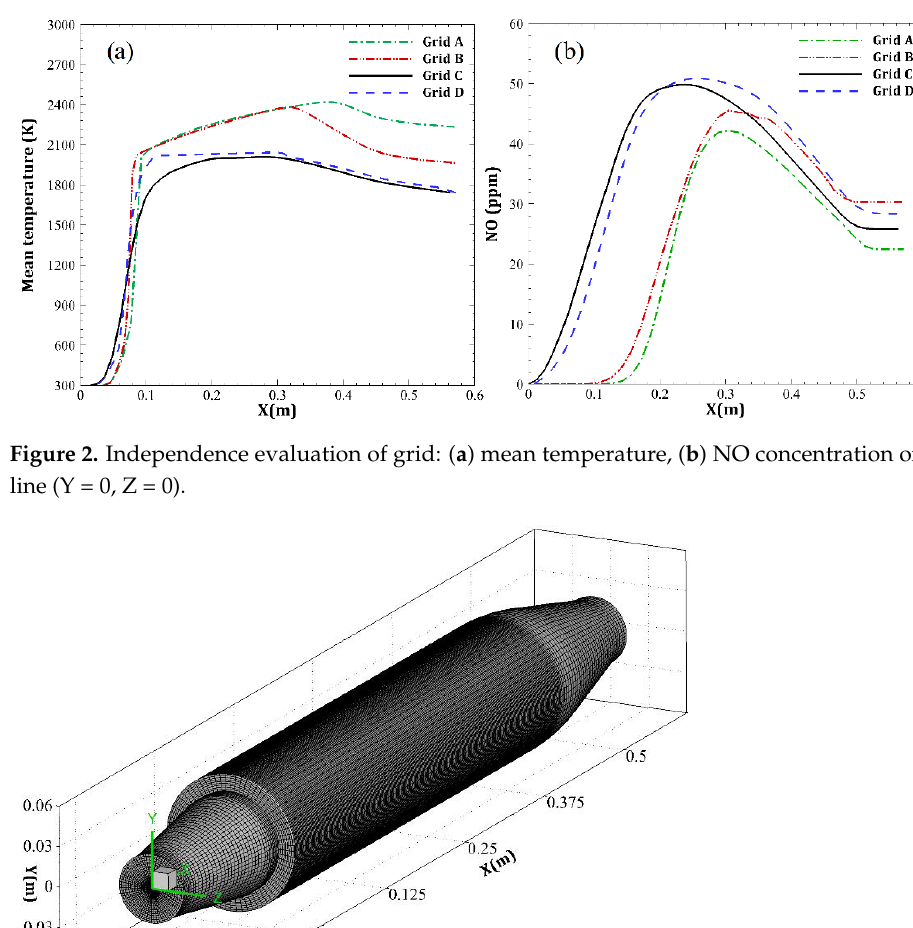
Figure 2. Independence evaluation of grid: ( a ) mean temperature, ( b ) NO concentration on center line (Y = 0, Z = 0).